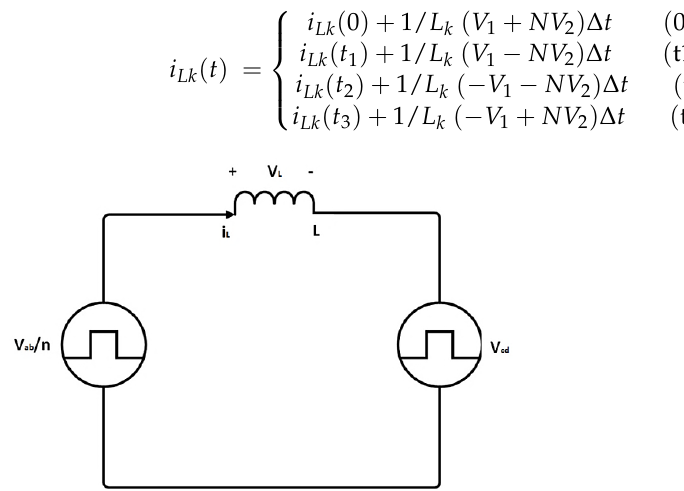
Energies 2022 , 15 , x FOR PEER REVIEW Figure 4. Equivalent model of DAB–DC/DC converter. Figure 4. Equivalent model of DAB–DC/DC converter.